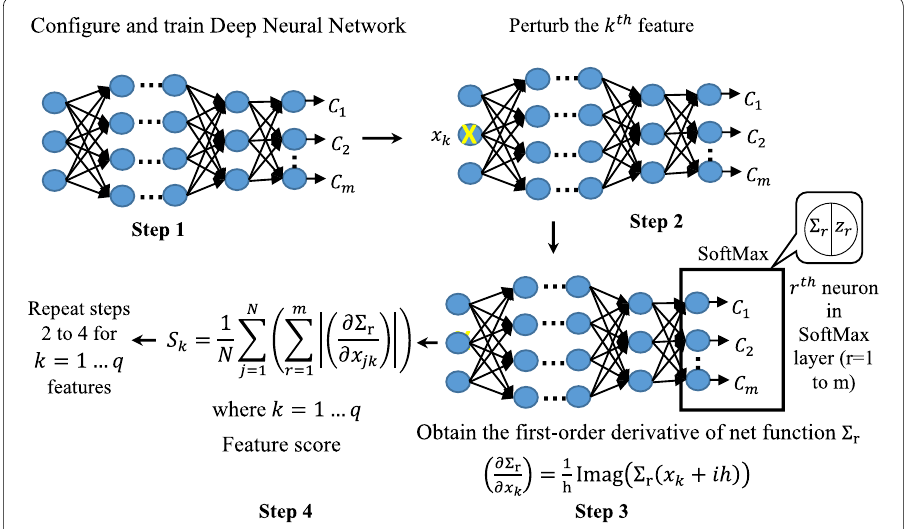
Fig. 2 Steps involved in the complex-step sensitivity for the classification